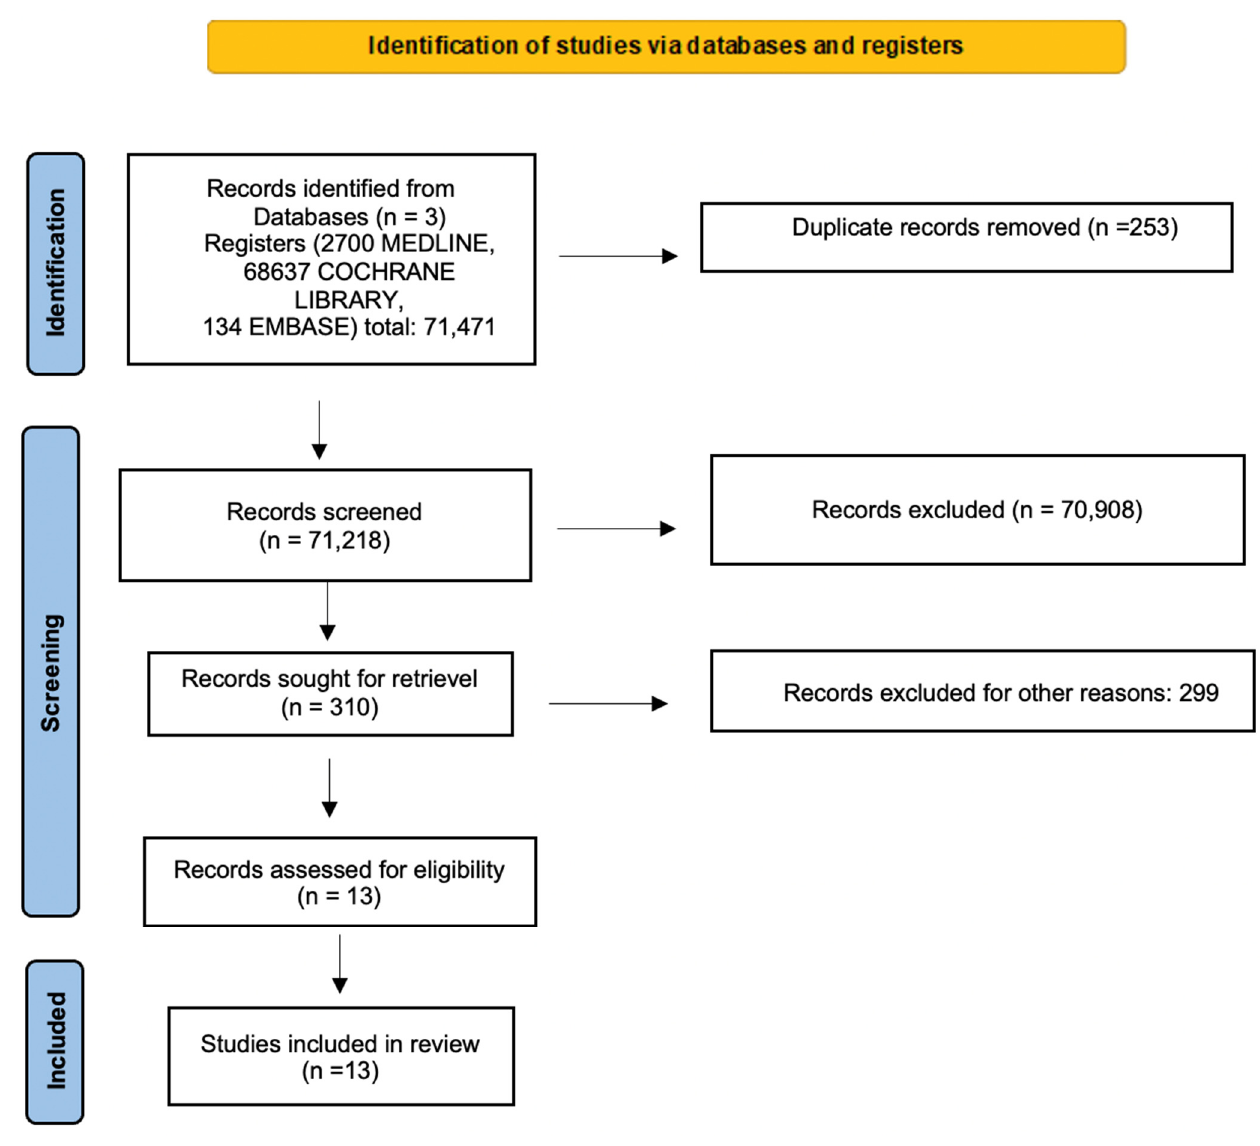
Figure 1. PRISMA (Preferred Reporting Items for Systematic Reviews and Meta-Analyses) flow chart.